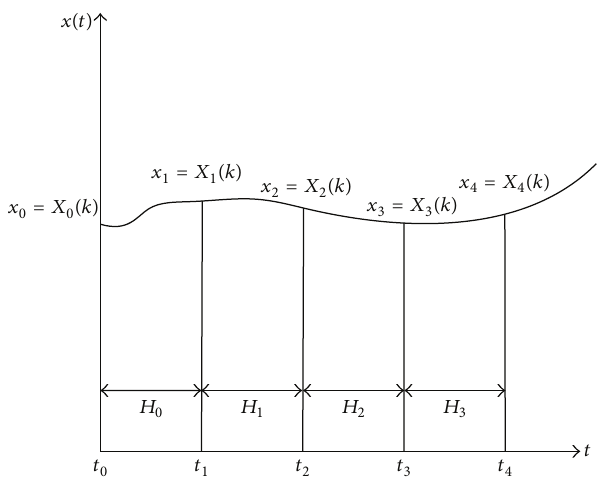
Figure 8: Time step diagram.